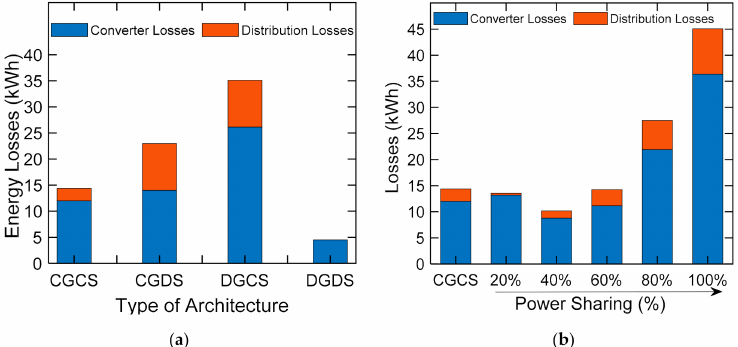
Figure 12. ( a ) Energy loss comparison among four architectures for one-day operation ( b ) energy loss comparison between CGCSA and DGDSA with various power-sharing